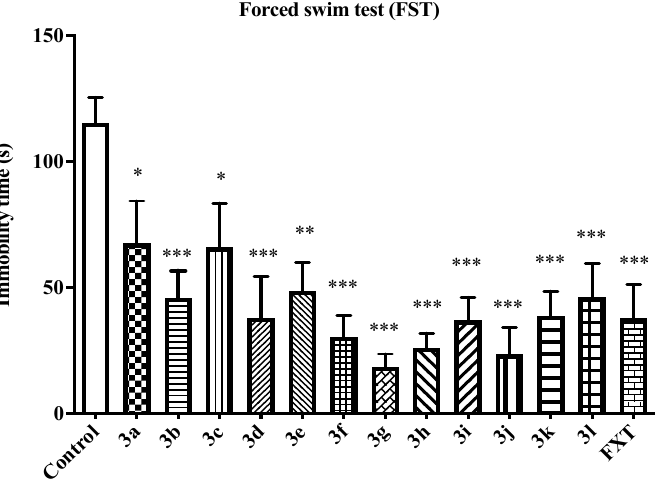
Figure 2. Effects of compounds 3a – l and FXT (i.p., 50 mg/kg) on the duration of immobility time in the FST. Ten animals were used for each group. * p < 0.05 compared to the control group, ** p < 0.01 compared to the control group, *** p < 0.001 compared to the control group.